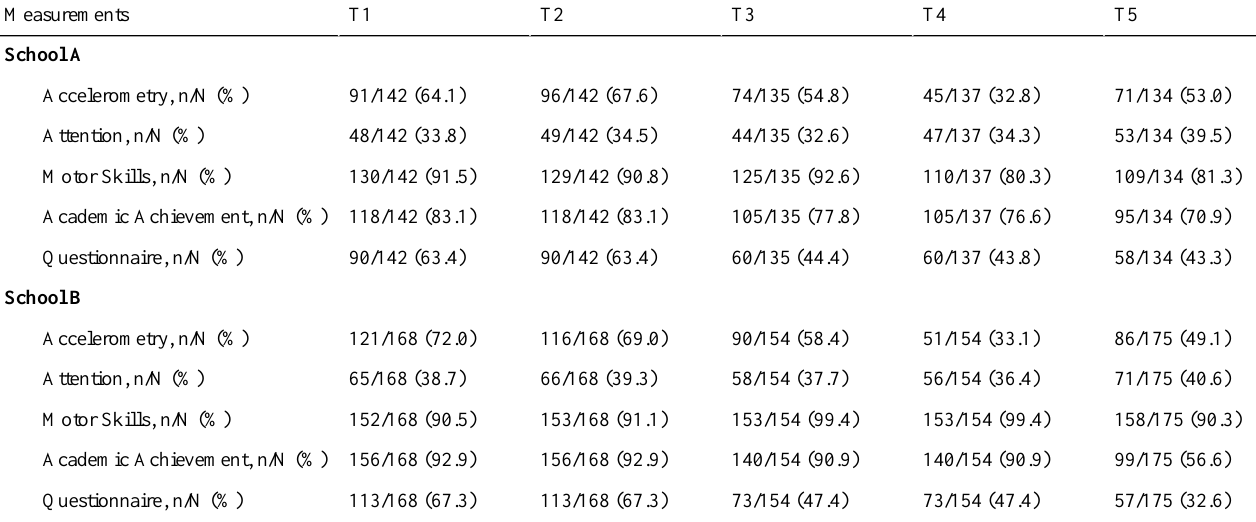
Table 1. Children’s participation in baseline, follow-up, and final assessments in the 2 schools.